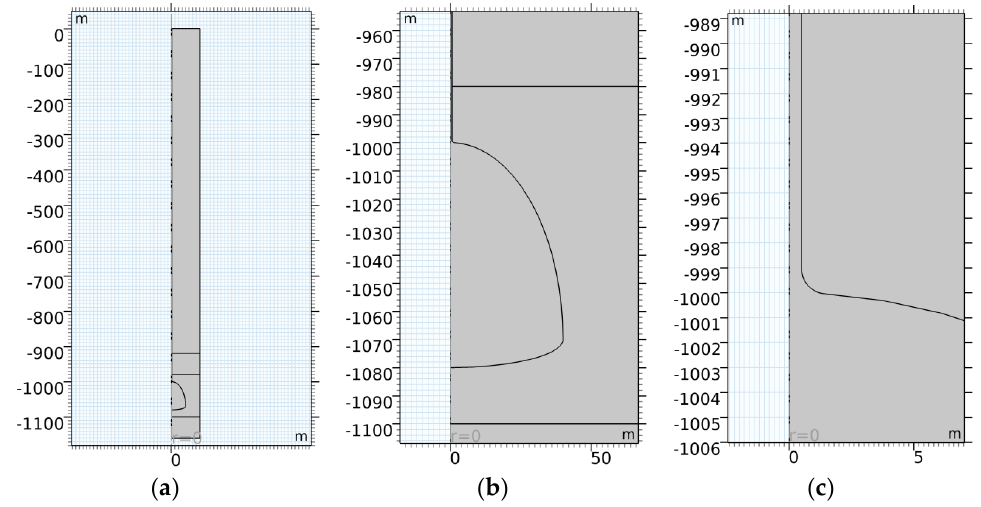
Figure 2. ( a ) Integration model of wellbore and cavity. ( b ) Shape of salt cavity. ( c ) Connection section between wellbore and salt cavity.